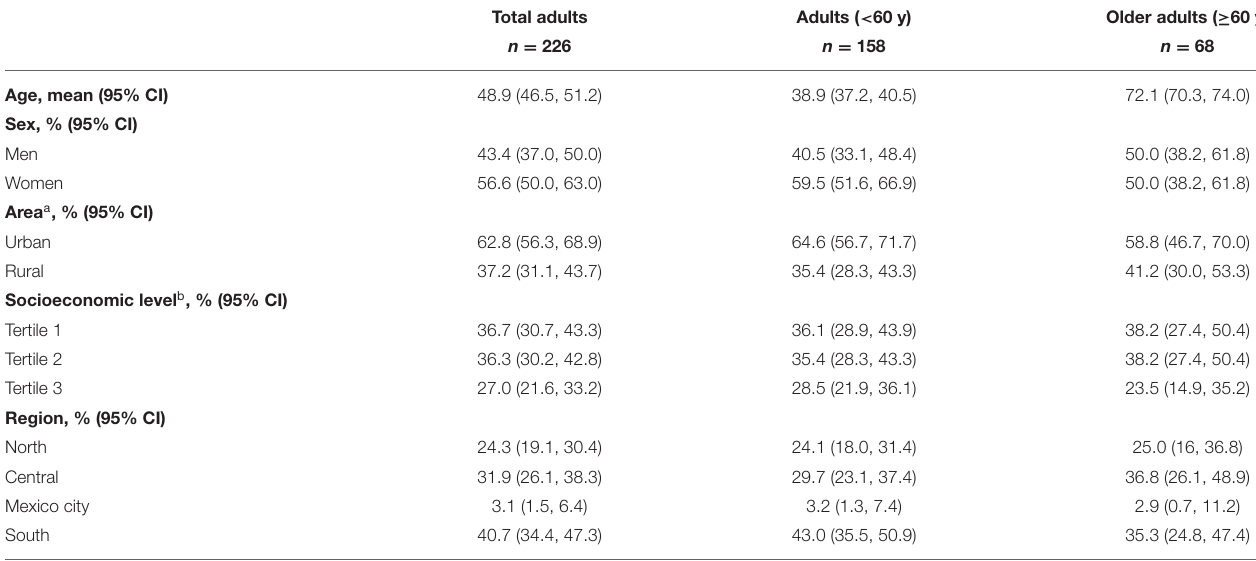
TABLE 1 | Characteristics of the participants in the relative validation study.